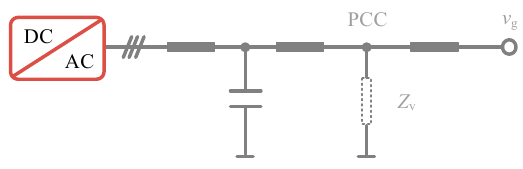
Figure 4. Virtual impedance equivalently connected at the capacitor branch.